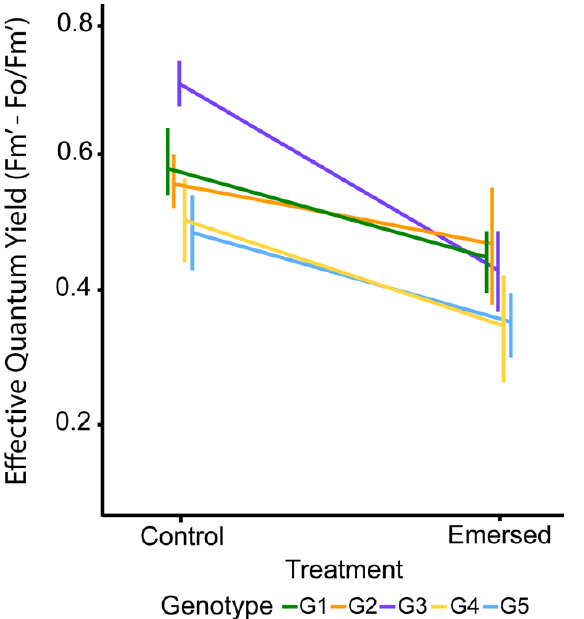
Figure 3. Reaction norms of all genotypes showing changes in Φ PSII following exposure to increased emersion duration.